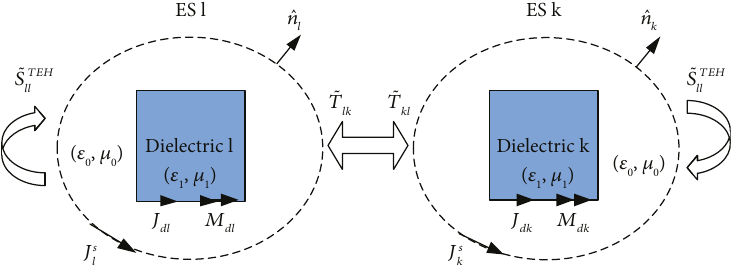
Figure 5: The translation operator of two nonadjacent